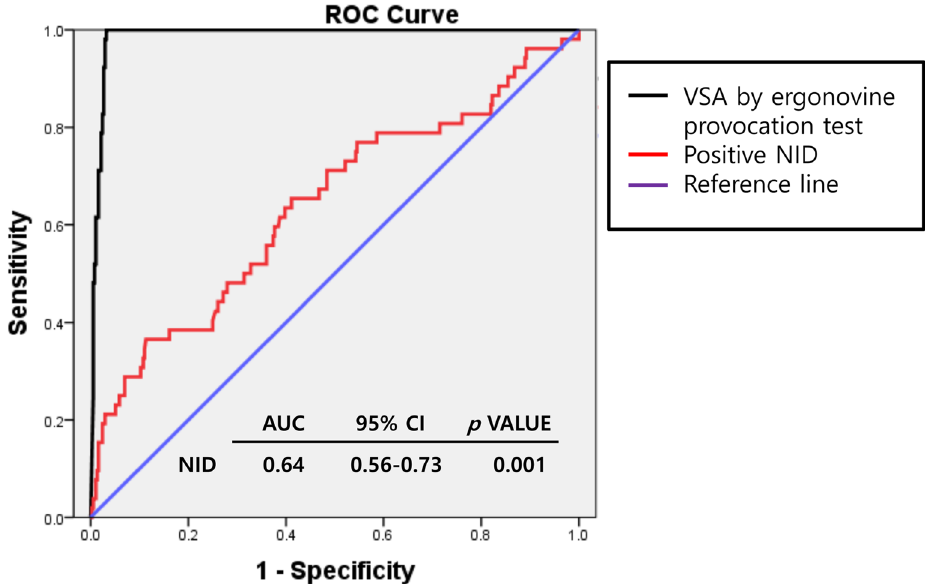
Figure 4. Receiver operating characteristic (ROC) curve analysis of the coronary response of IC nitroglycerin infusion for positive VSA patients according to ergonovine provocation test. Abbreviations: ROC receiver operating characteristic, AUC area under the curve, CI confidence interval, VSA vasospastic angina, NID nitroglycerin-induced dilation.